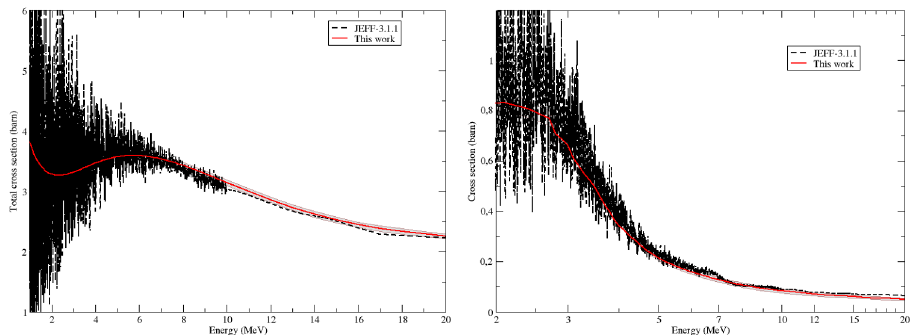
Figure 1. Total (left) and first-level-inelastic scattering (right) cross sections of JEFF-3.1.1 (dashed line) and the cross sections with corresponding uncertainties obtained in the present work